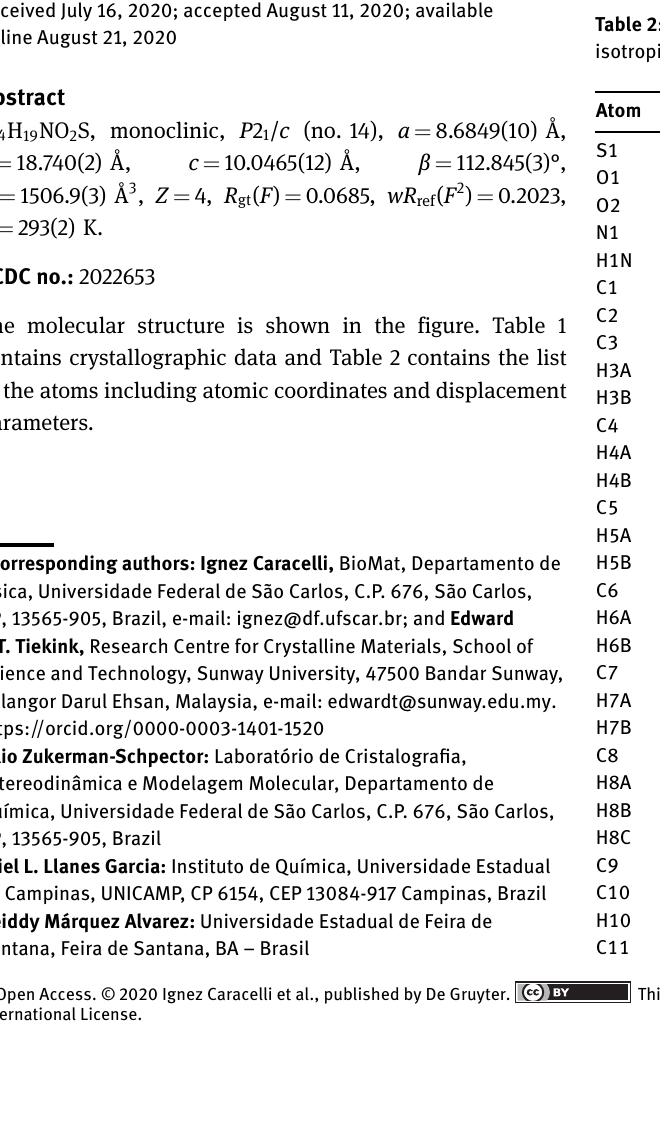
Table 2: Fractional atomic coordinates and isotropic or